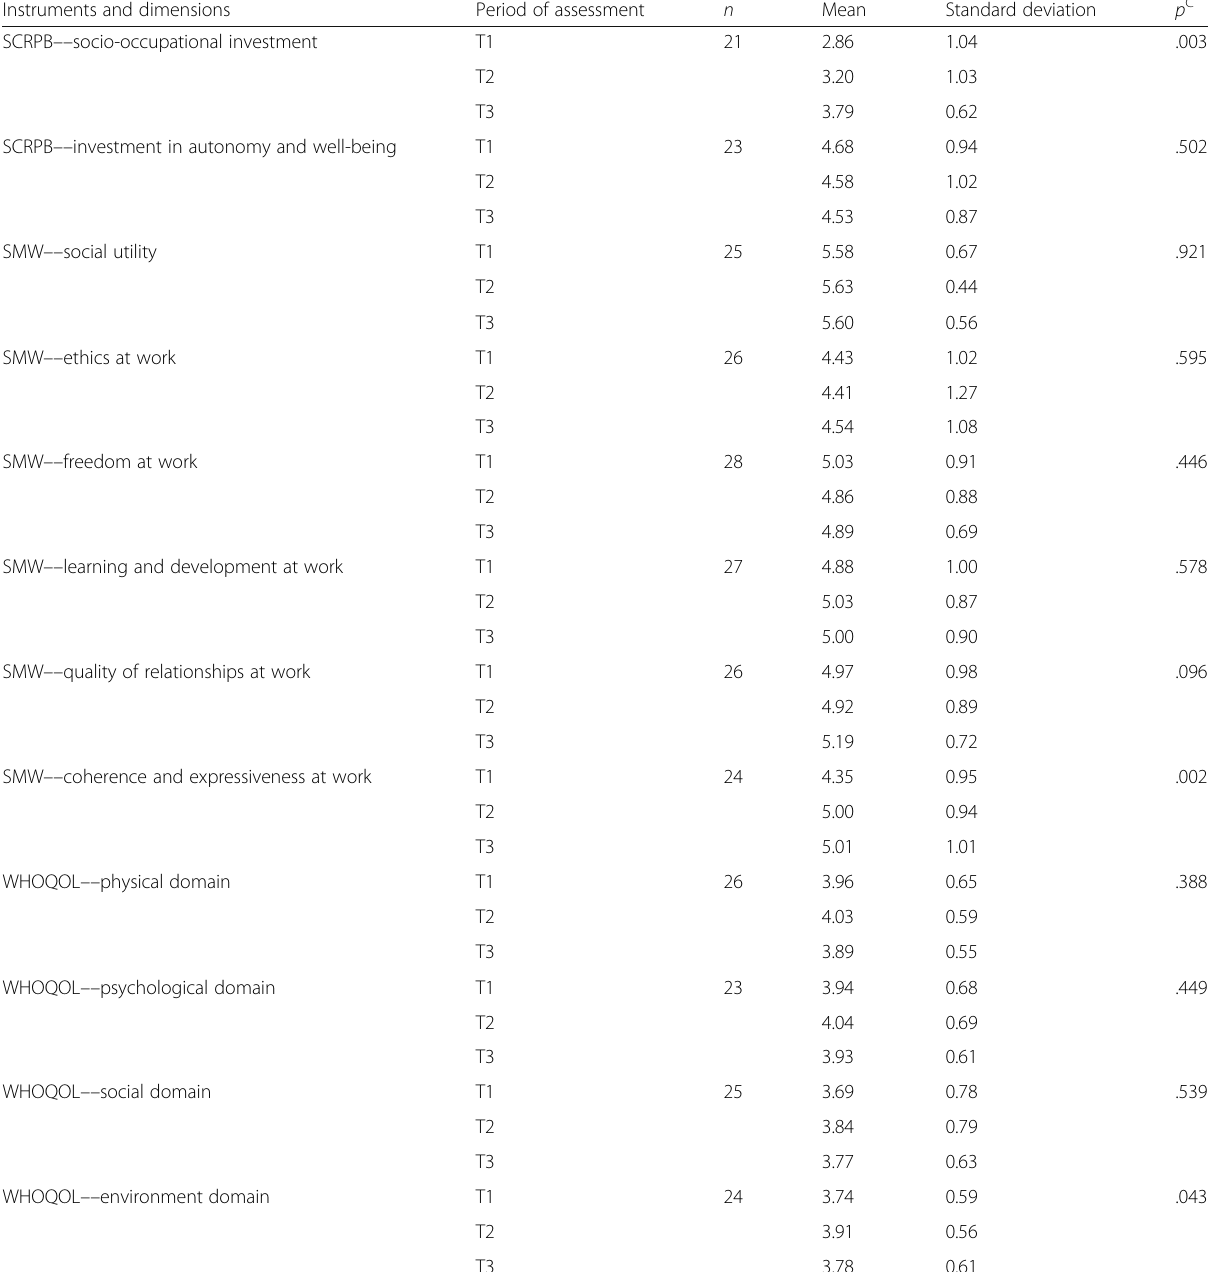
Table 2 Mean and standard deviation for the instruments SCRPB, SMW, and WHOQOL-Brief, according to the assessments in T1, T2, and T3 for the EG Instruments and dimensions Period of